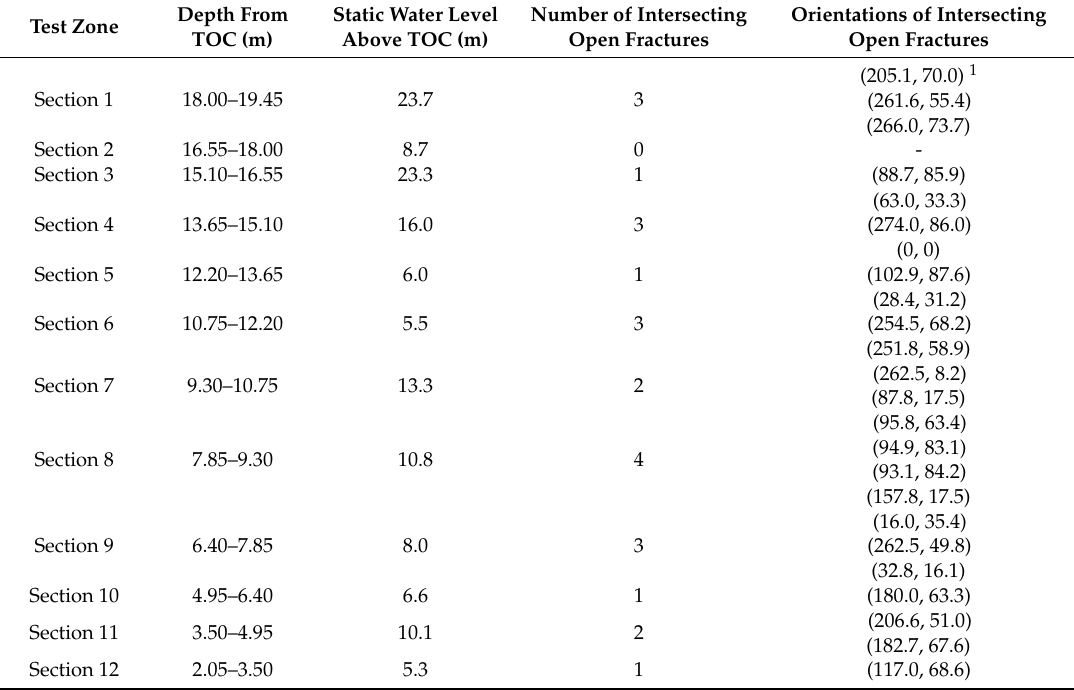
Table 1. Locations of the test zones and the static groundwater levels and intersecting open fractures in the test